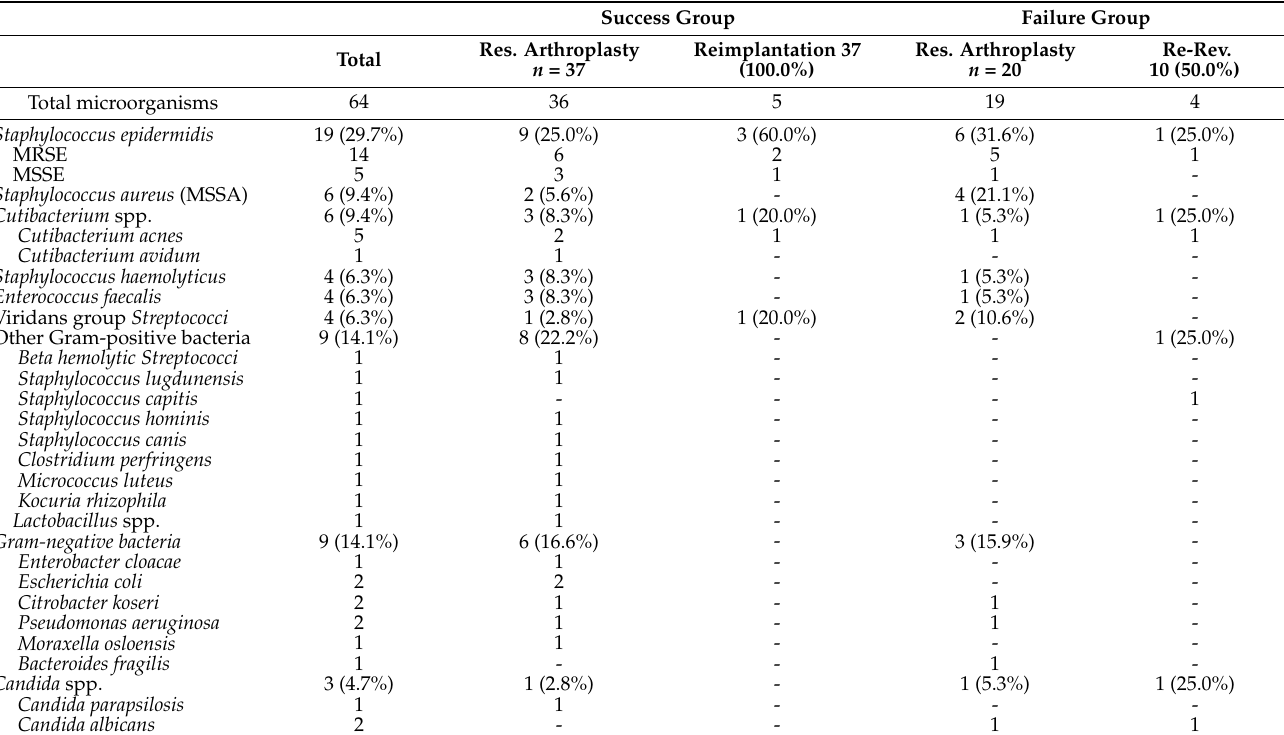
Table 3. Microorganisms identified during resection arthroplasties, reimplantations and re-revision surgeries in successful two-stage procedures (success group) and failed two-stage procedures (failure